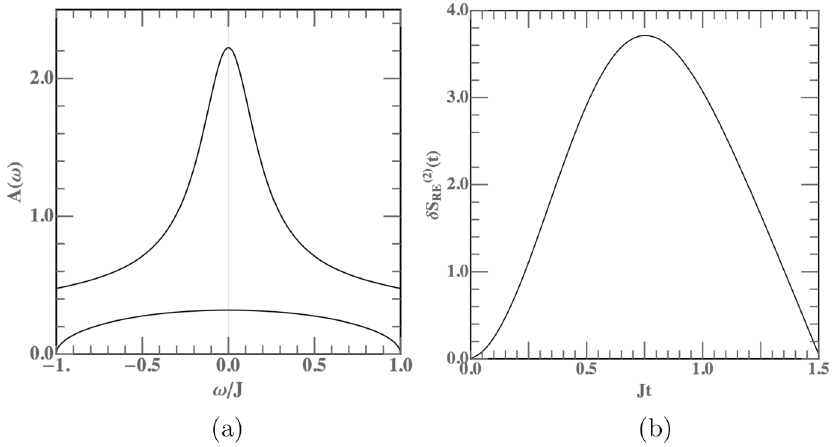
Figure 3 . Evaporation of “Black Hole”, In (a) we show the spectral function of the system (SYK 4 model, β = 2 , J = 2 ) and the environment (SYK 2 model with β = 20 , J 0 = 2 ); in (b), we show the Rényi entropy response of the sudden coupling between SYK model and the environment. As the environment is at low temperature, it is an evaporation process. We can see a linear growth follows a quadratic growth, then a sharp linear drop follows. The shape of the curve is alike the Page curve in black hole evaporation. g 2 NM is tuned for showing the figures, but these values are not important at this